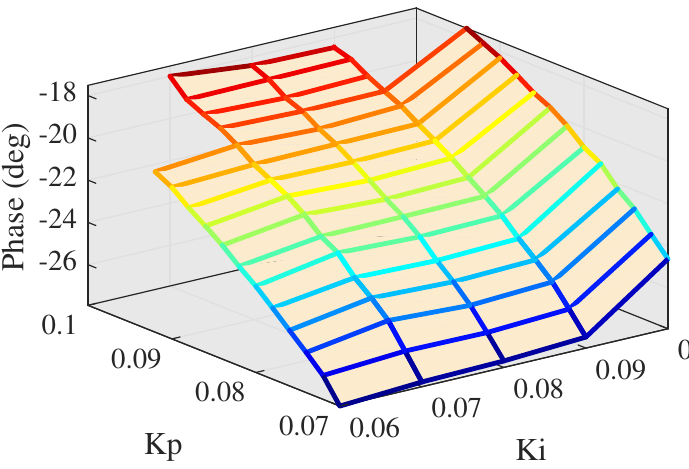
Figure 25. Amplitude at high level PI.